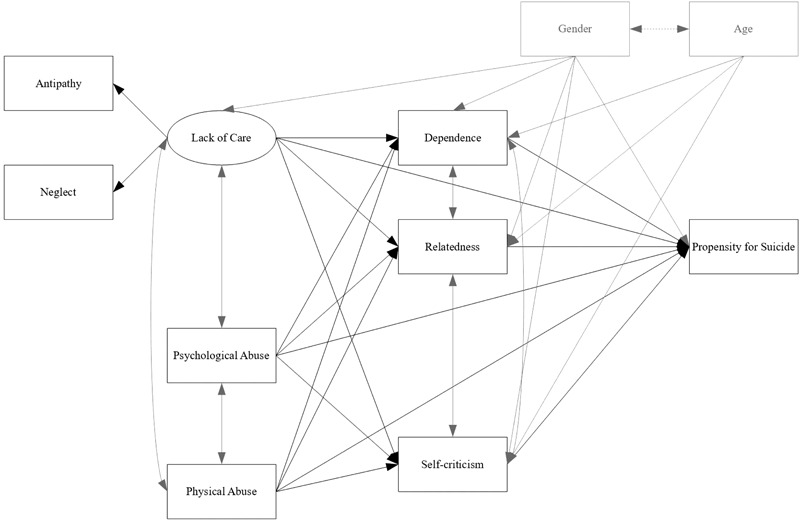
The theoretical model of the study. Covariances, control variables, and their related paths are presented in light gray.